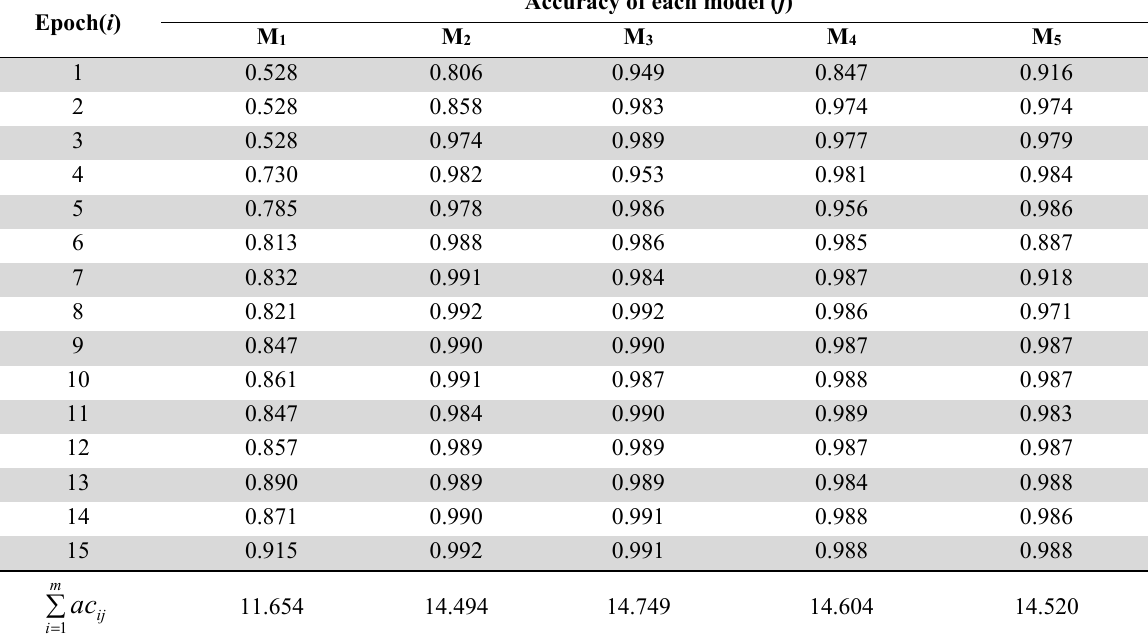
The Validation Accuracy of Conventional Models on the ISOT fake news dataset Epoch( i